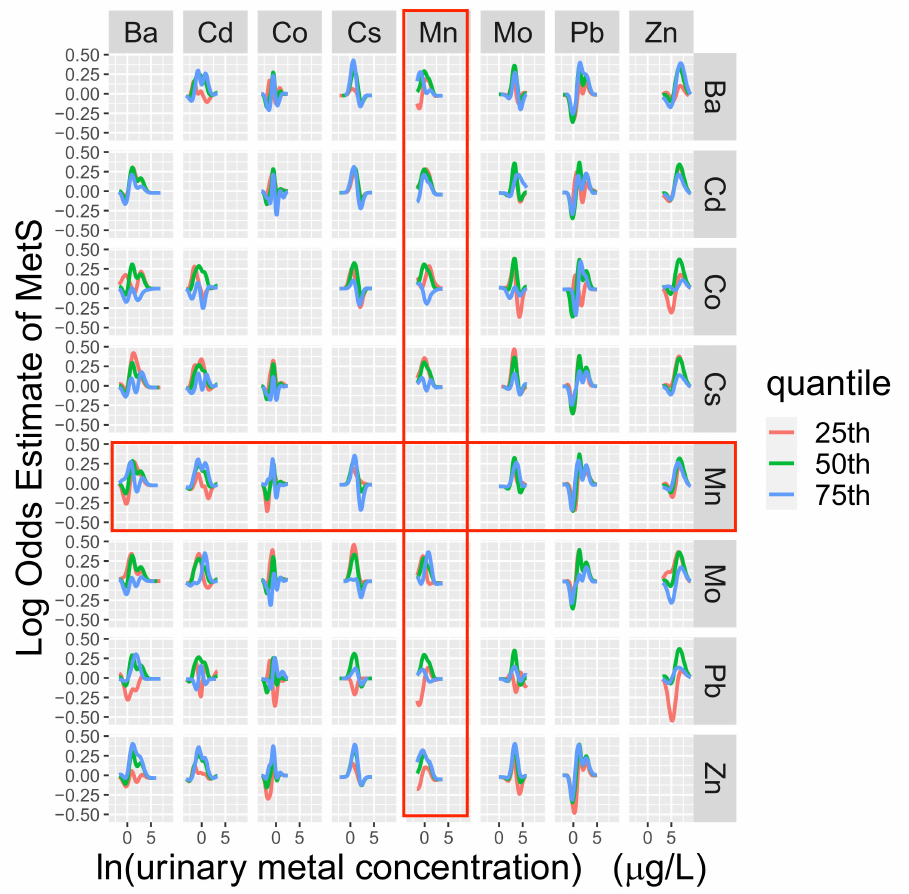
Figure 2. Bayesian kernel machine regression model of the cross-sectional associations between natural log-transformed (ln) metals and metabolic syndrome (MetS). Figure Legend: Metals along the y axis are categorized into quartiles. Red outlined plots represent interactions between Mn and other metals. Parallel dose–response lines indicate that interaction is not present. Models were adjusted for baseline values of sex, age (years), ethnicity (Hispanic, non-Hispanic), annual gross household income (<USD 10,000, USD 10,000–24,999, ≥ USD 25,000), smoking status (<100 cigarettes in lifetime (never), ≥ 100 cigarettes in lifetime and does not currently smoke (former), ≥ 100 cigarettes in lifetime and currently smokes (current)), caloric intake (kcal/day), and urinary creatinine (g/L). Metabolic syndrome was defined as having three or more of the following outcomes: (1) waist–hip ratio (waist circumference divided by iliac circumference) >0.90 for males, waist–hip ratio >0.85 for females, or a body mass index (measured weight divided by measured height squared) >30 kg/m 2 , (2) high density lipoprotein <40 mg/dL for males or <50 mg/dL for females, (3) triglycerides ≥ 150 mg/dL, (4) fasting glucose ≥ 100 mg/dL or diabetes (includes people who self-reported being diagnosed with diabetes via an oral glucose tolerance test or prescribed insulin or oral hyperglycemic medication), or (5) measured systolic blood pressure ≥ 130 mmHg or diastolic blood pressure ≥ 85 mmHg or self-reported current use of antihypertensive